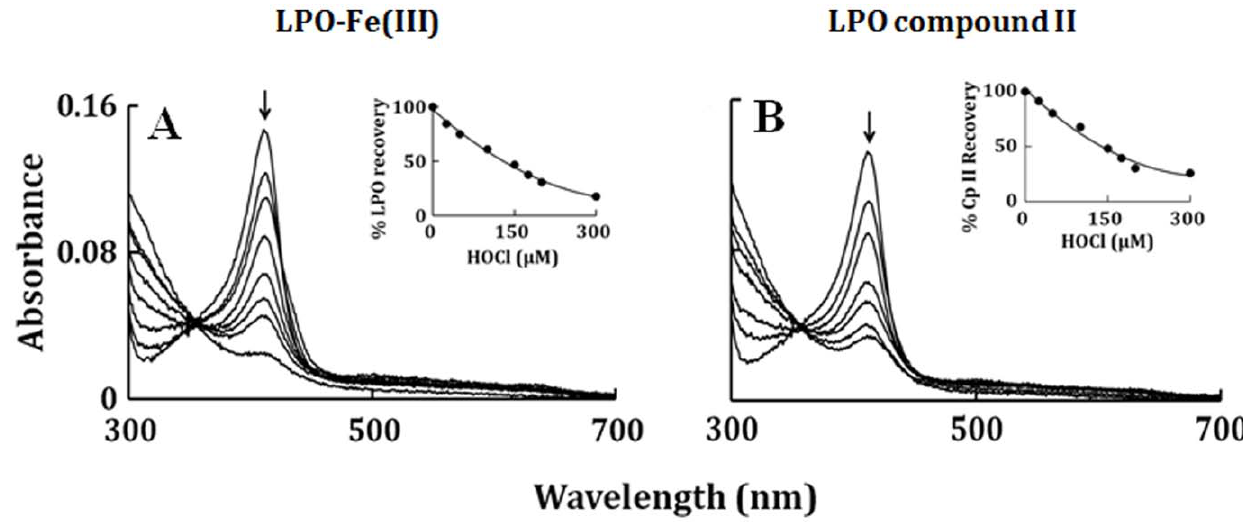
Figure 1. Optical absorbance spectra for concentration dependent of HOCl-mediated heme depletion of LPO-Fe(III) and LPO Compound II. Spectral traces were recorded after 2 h of incubation of a fixed amount (1.5 m M) of LPO-Fe(III) (Panel A) and LPO Compound II (Panel B) with increasing concentration of HOCl (0, 25, 50, 100, 150, 175, 200 and 300 m M), at 25 u C. Arrows in Panel A and B indicate the direction of spectral change. The LPO recovery estimated from the absorbance values at 432 from each spectral scan recorded in the Panels A and B are plotted versus HOCl concentration (Panel A and B insets). These data are representative of three independent experiments.